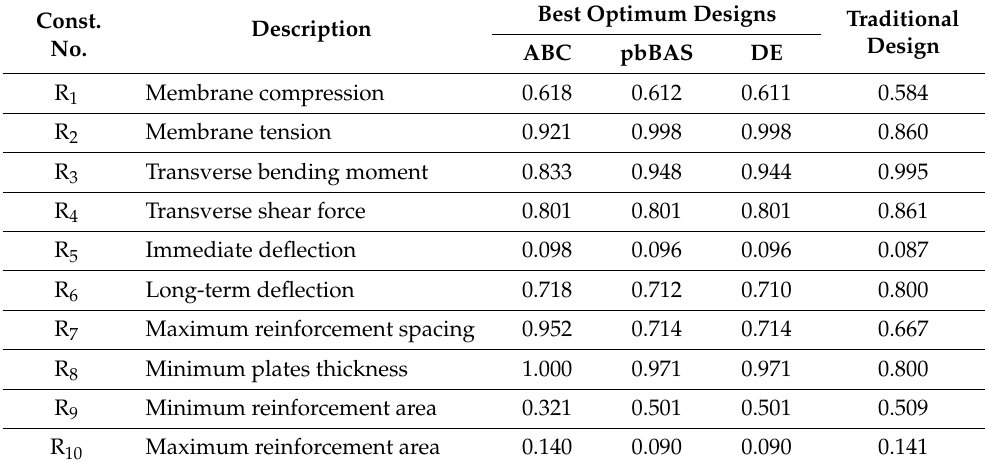
Table 27. The values of maximum demand capacity ratios of folded plate constraints in the opti- mum design achieved by each metaheuristic algorithm for the three-segment type folded plate roof building. Const.